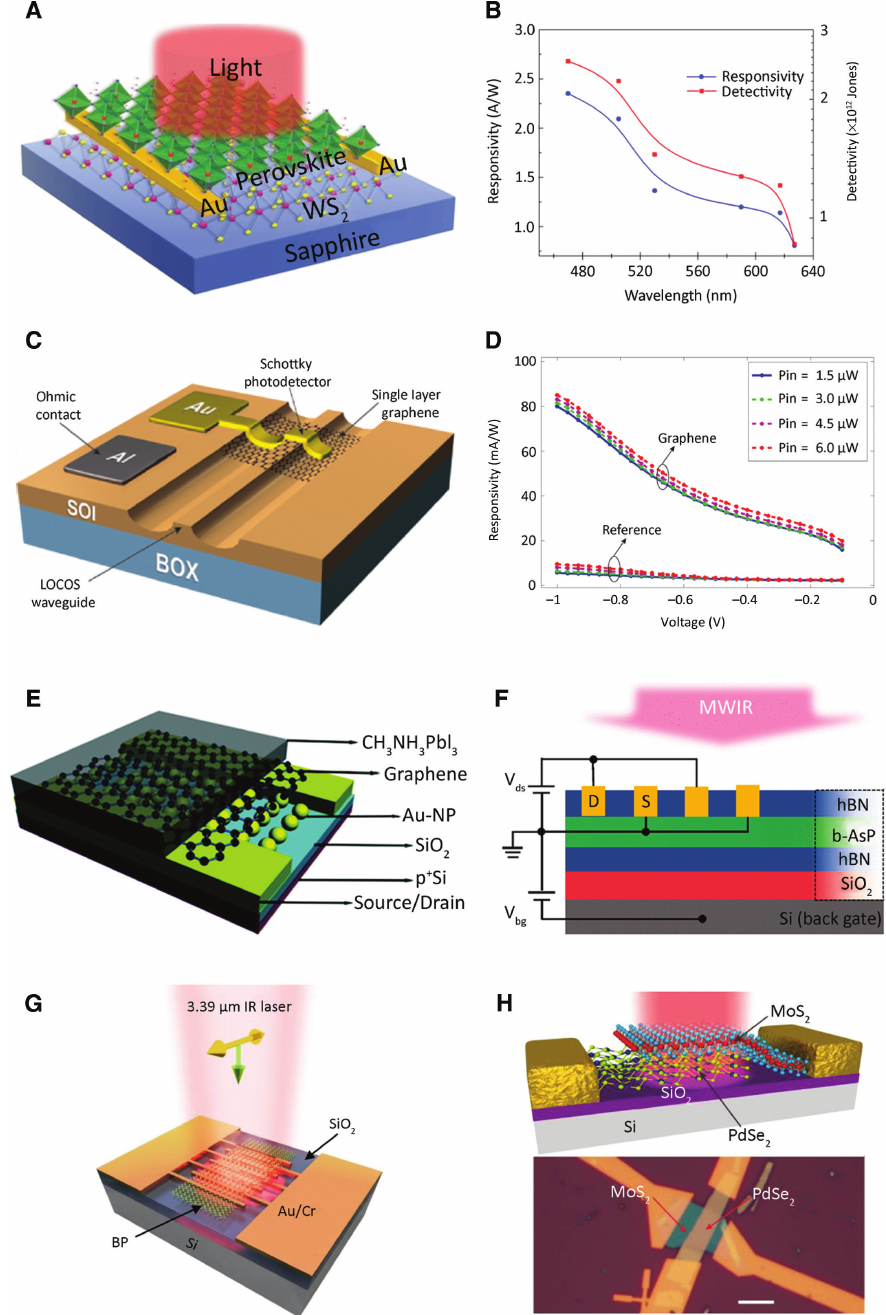
Figure 2: Demonstrations of 2D material-based photodetectors. (A) Schematic device structure of the hybrid WS /perovskite photoconductor fabricated on a C-plane (0001) sapphire substrate. (B) WS 2 perovskite photoconductor’s photoresponsivity and detectivity performance (A and B reproduced from [76] with permission from Advanced Materials). (C) Si-single layer Schottky photodetectors integrated with local oxidation of Si (LOCOS) waveguides. (D) The responsivity of metal-single layer graphene-Si and reference metal-Si photodetectors as a function of reverse bias for different optical powers coupled to the Schottky region (C and D reproduced from [64] with permission from Nano Letters). (E) Schematic of the CH nanoparticle photodetector hybrid architecture (E reproduced from [78] with permission from Nano Scale). (F) The cross-sectional schematic of the as-fabricated hBN/b-As P /hBN heterostructure photodetector (F reproduced from [71] with permission from Nano Letters). 0.83 0.17 (G) Illustration of the BP metal-semiconductor-metal photodetector operating at 3.39 μ m. The polarization of the incident laser and its incident direction are represented by yellow and green arrows, respectively (G reproduced from [68] with permission from Nano Letters). (H) Top panel: schematic image of the PdSe -MoS infrared photodetector. Bottom panel: optical photograph of the PdSe 2 2 scale bar 5 μ m (H reproduced from [75] with permission from ACS